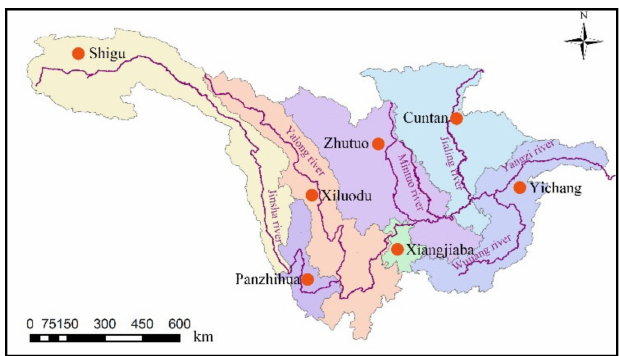
Figure 2. Sub-basins of upstream Yangtze River based on seven main control